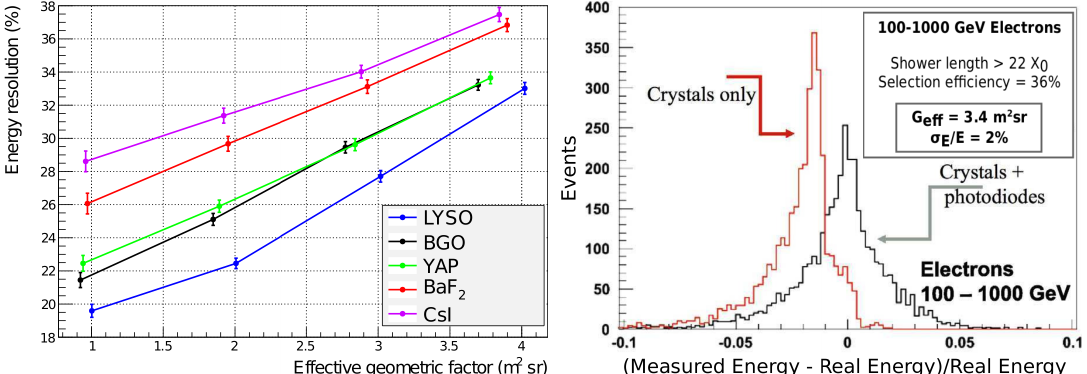
Figure 2. Left panel : Average energy resolution as a function of the effective geometric factor, obtained by applying a progressively looser cut on the shower length in the case of 1 TeV protons; Right panel : energy resolution of the detector for 100–1000 GeV incident electrons, in case of the energy deposit in crystals only (red) or in both crystals and photodiodes